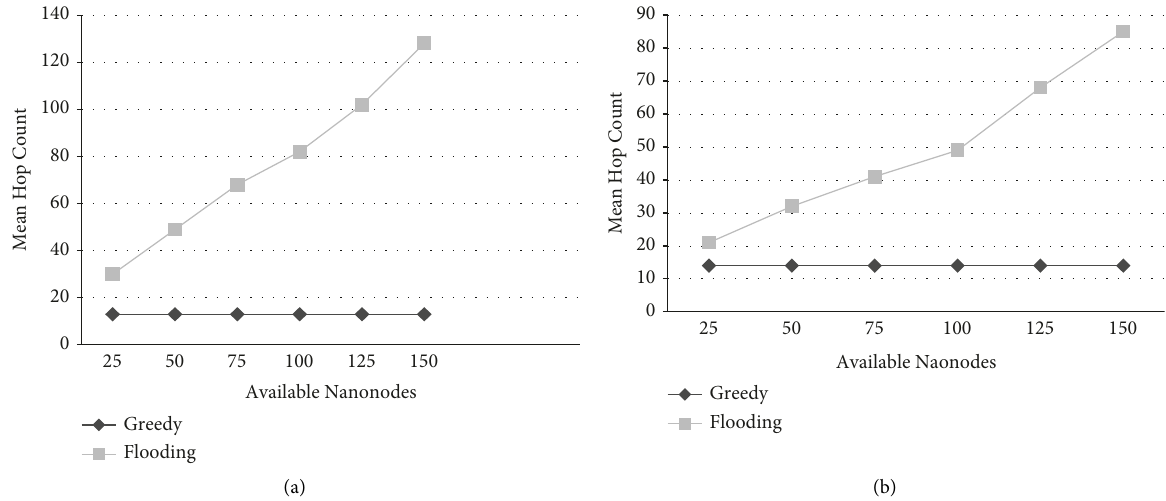
Figure 22: (a) Mean hop count when transmitted packet range is 0.01m. (b) Mean hop count when transmitted packet range is